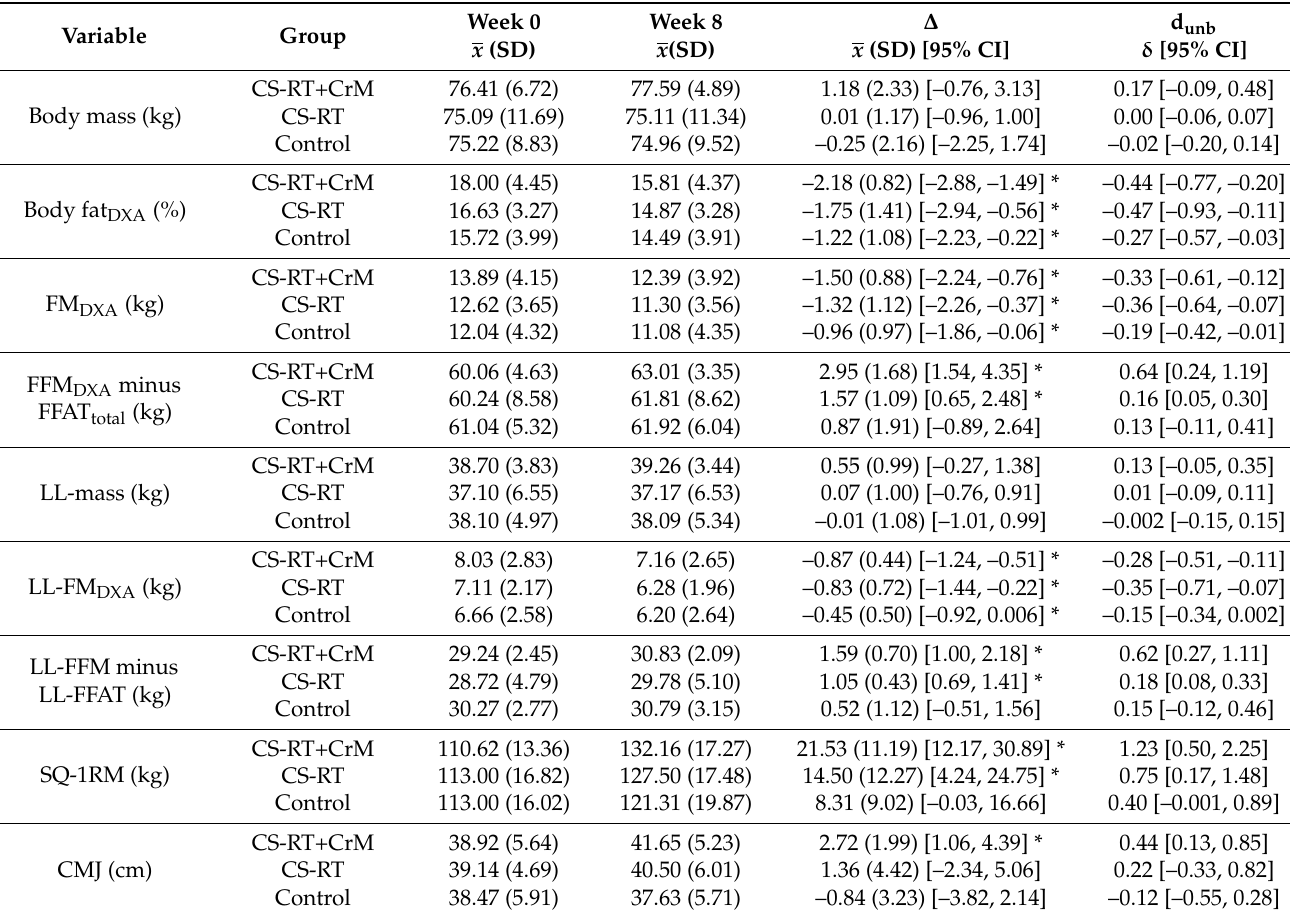
Table 3. Pre- and post-intervention data on the main study